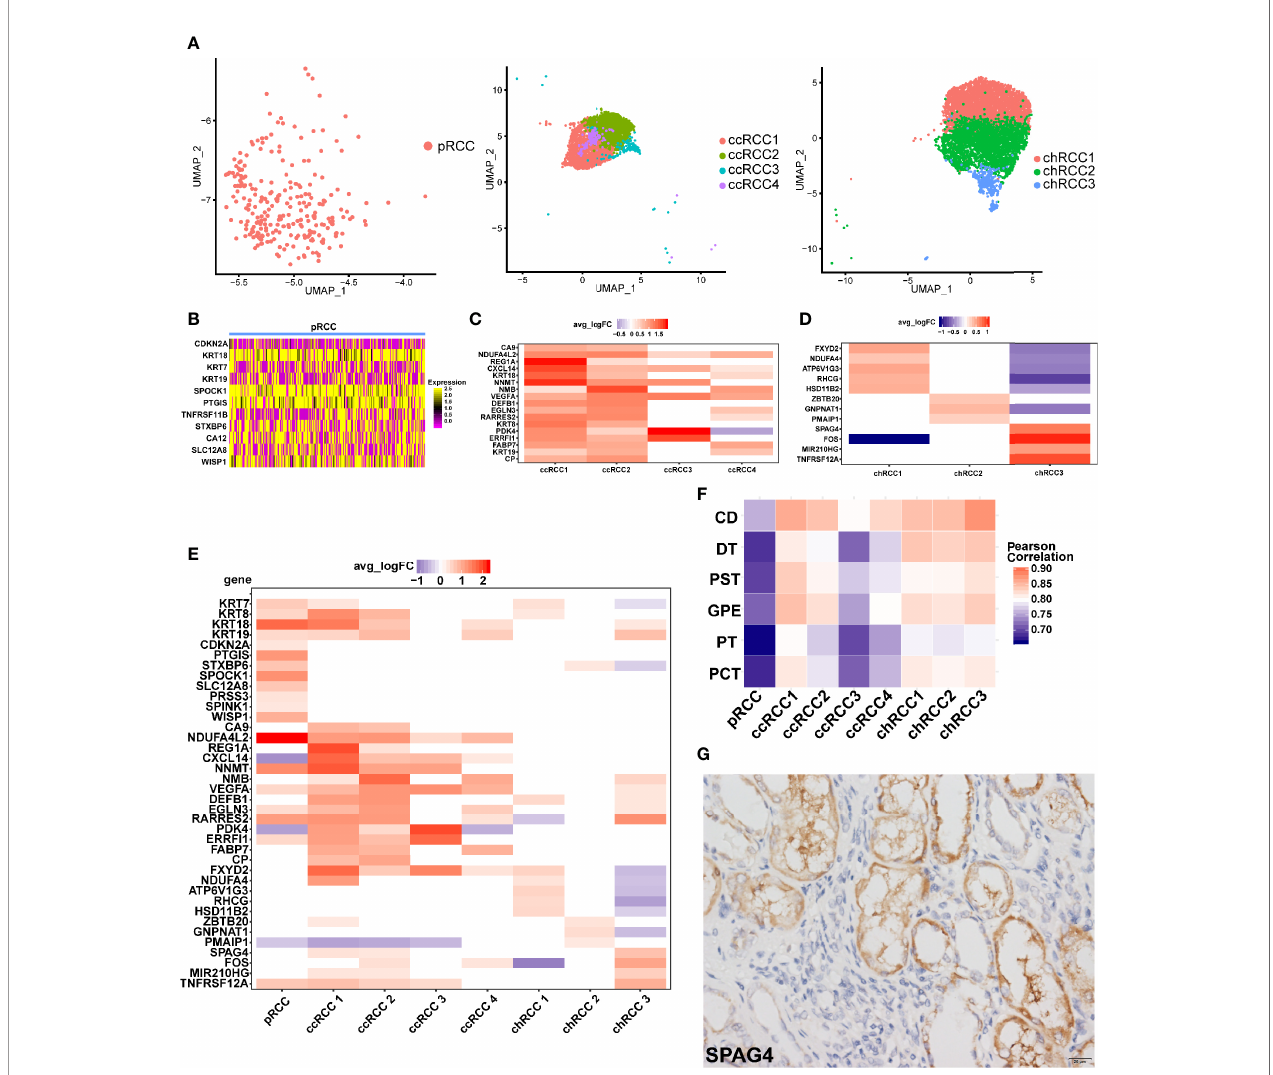
FIGURE 2 | ScRNA-seq revealed tumor heterogeneity of RCC. (A) UMAP plot of the tumor cells in different pathologic types (type 2 pRCC, ccRCC and chRCC). (B – D) DEGs of different pathologic types of RCC, as shown by scRNA-seq, avg logFC and average log2 fold change. (E) Comparison of DEGs in different pathological RCCs. (F) Comparison of normal kidney cell types with RCC cell types by calculating the Pearson correlation coef fi cient. CD, collecting duct cells; DT, distal tubule cells; PST, proximal straight tubule cells; GPE, glomerular parietal epithelial; PT, proximal tubule cells; PCT, proximal convoluted tubule cells. (G) IHC-P veri fi cation of SPAG4 positive cells in chRCC tissue. Scale bars, 20 m